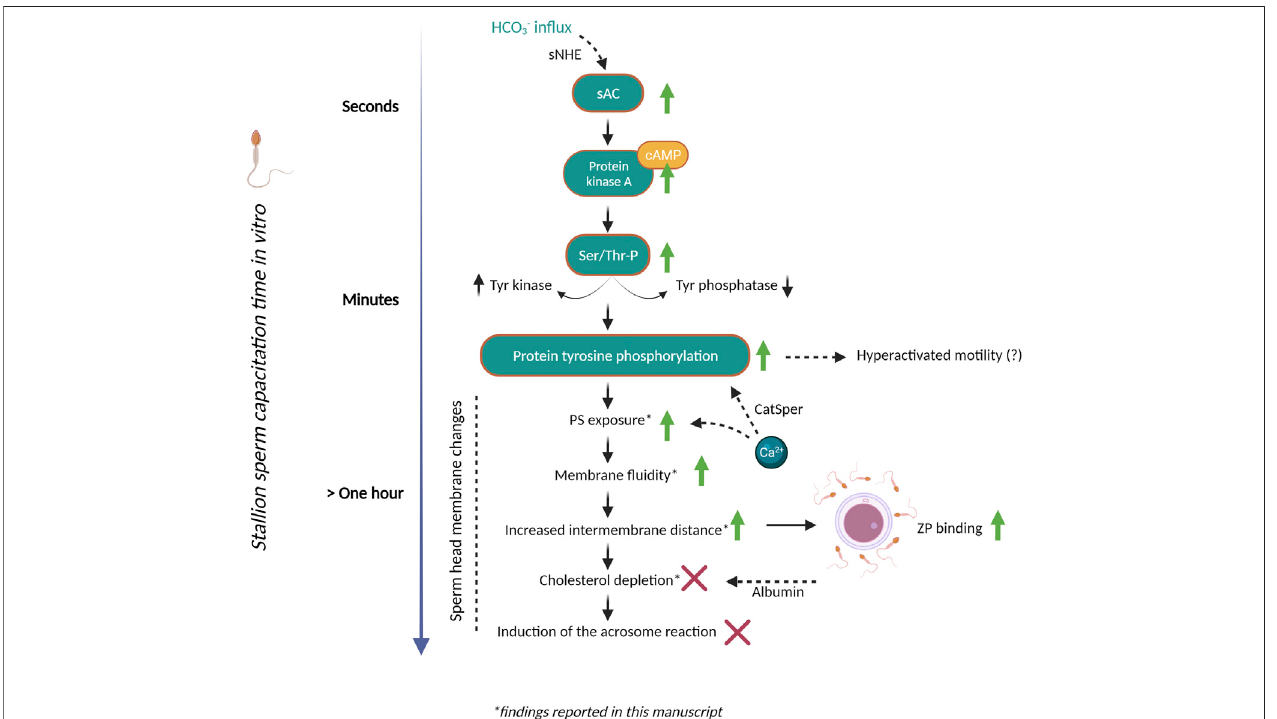
FIGURE 8 | Steps towards stallion sperm capacitation in vitro and ongoing challenges. A number of changes must take place in the sperm head membrane to permitinteractions with the oocyte. In the stallion we now know that the bicarbonate induced membrane fl uidity changes that facilitate downstream sperm functions are regulated by soluble adenylyl cyclase. This leads to an increase in cyclicAMP levels, the regulation of tyrosine kinases and phosphatases and an increase in protein tyrosinephosphorylation(asreportedinindependentstudies).Wehavedemonstratedherethatapopulationofstallionspermcellsalsoexposephosphatidylserine (PS)intheouterlea fl etoftheplasmamembraneduringthisprocessbutremainviable.Usingcryo-electrontomographywehaveobserveddistinctchangesinthestallion spermmembrane(suchasalteredintermembranedistance)inresponsetobicarbonate.However,thesemorphologicalmembranechangeswerenotaccompaniedbya signi fi cantchangeinmembranephospholipidcomposition,norcholesterolef fl ux.Thelackofcholesterolef fl uxmaybeauniqueaspectofstallionspermcapacitationthat differsfrom other speciesstudied,such as theboar. However, thesedatamay indicate thatbicarbonate-enriched capacitationmedia isinsuf fi cient topermitacomplete capacitation of stallion sperm cells. Indeed, the fi eld lacks a reliable method to induce acrosomal exocytosis in vitro . This incomplete capacitation may underpin our inability to conduct IVF in the horse. Further research should be focused around elucidating the “ slower ” aspects of the capacitation process that permit the acrosome reaction and sperm-egg fusion. Abbreviations: HCO 3 − , bicarbonate; sNHE, sperm-speci fi c Na + /H + exchanger; sAC, soluble adenylyl cyclase; cAMP, cyclic adenosine monophosphate; PKA, protein kinase A; Ser/Thr-P, serine/threonine phosphorylation; Tyr, tyrosine. This fi gure was created with BioRender.com.